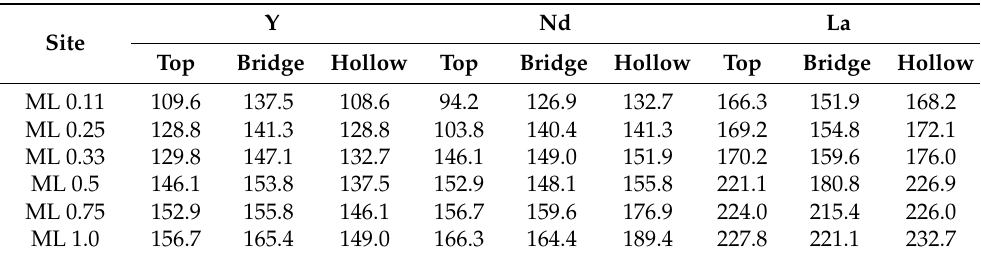
Table 1. The adsorption energy E ads (kJ/mol) of REEs (REEs = Y, Nd, and La) adsorbed on the (001) surface of kaolinite at different